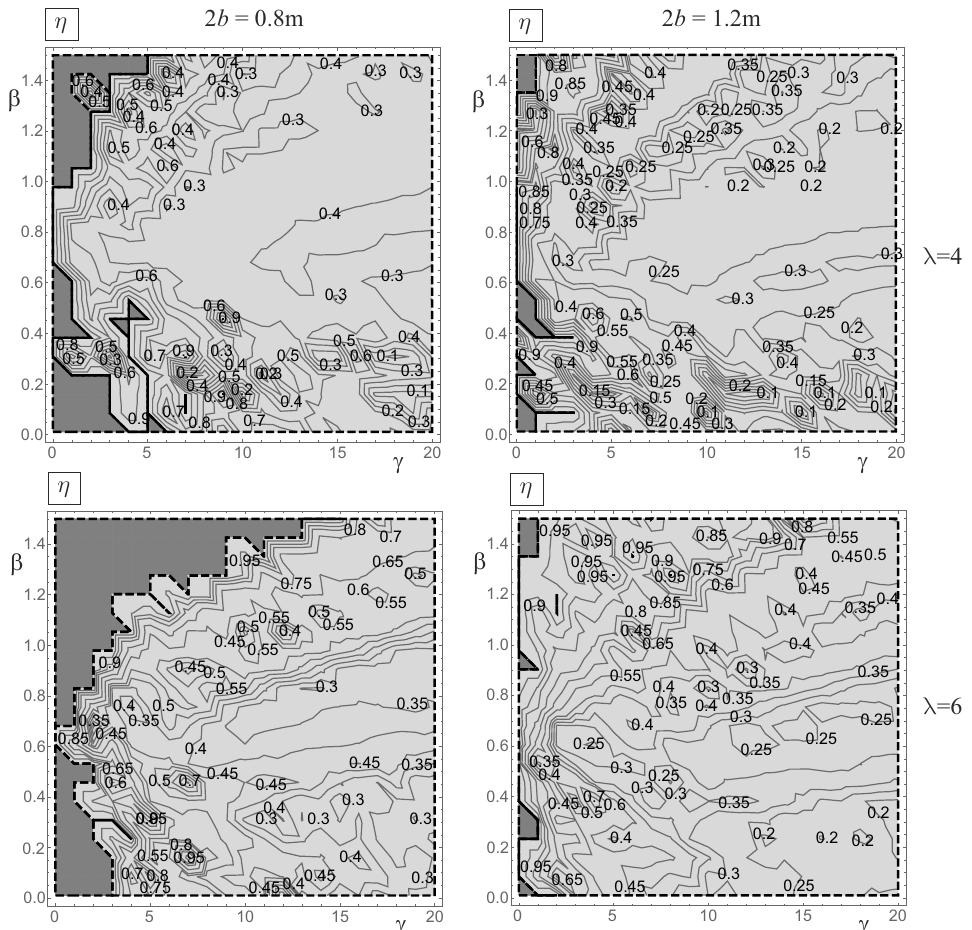
Figure 13. Gain maps obtained for different dimensions of the rigid blocks and under the Newhall seismic record ( m = 0.05 M , u y = 1/3 u cr , ψ =